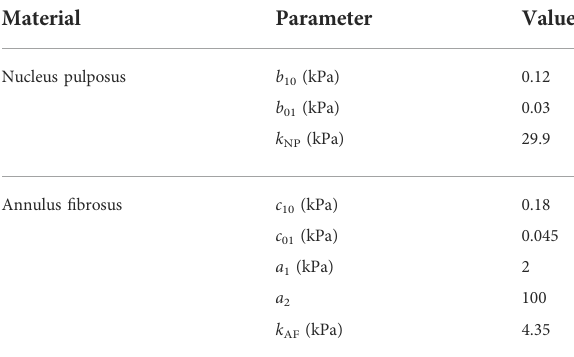
TABLE 1 Material model parameters of NP and AF, where k NP and k AF are obtained from their respective Poisson ’ s ratios of 0.495 (Ayturk et al., 2012) and 0.45 (Goel et al.,